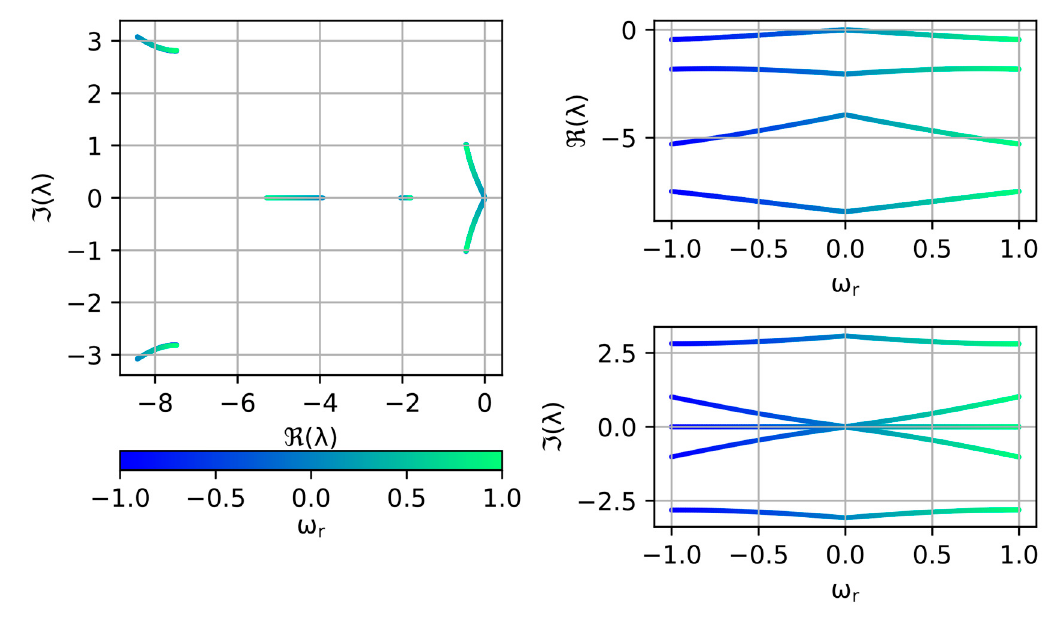
Figure 10. Poles placement of the observer in the function of the rotor speed under nominal rotor flux module and no load with modified gains after a rotation direction change.